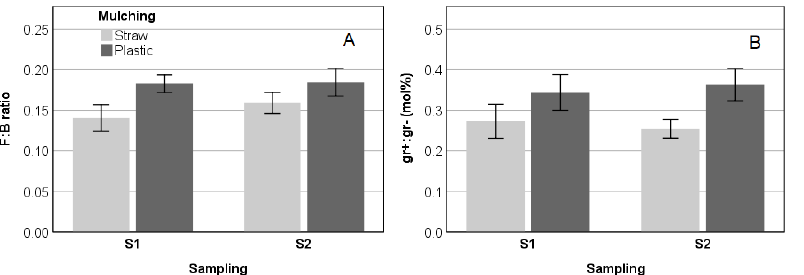
Figure 2. Structure of soil microbial communities as determined by PLFA analysis differentiated by mulching system (straw vs. plastic mulching) and sampling date: April (S1) and May (S2). ( A ): Molar % ratio of fungi to bacteria (F:B); ( B ): Molar % ratio Gram-positive to Gram-negative bacteria (gr+:gr − ).